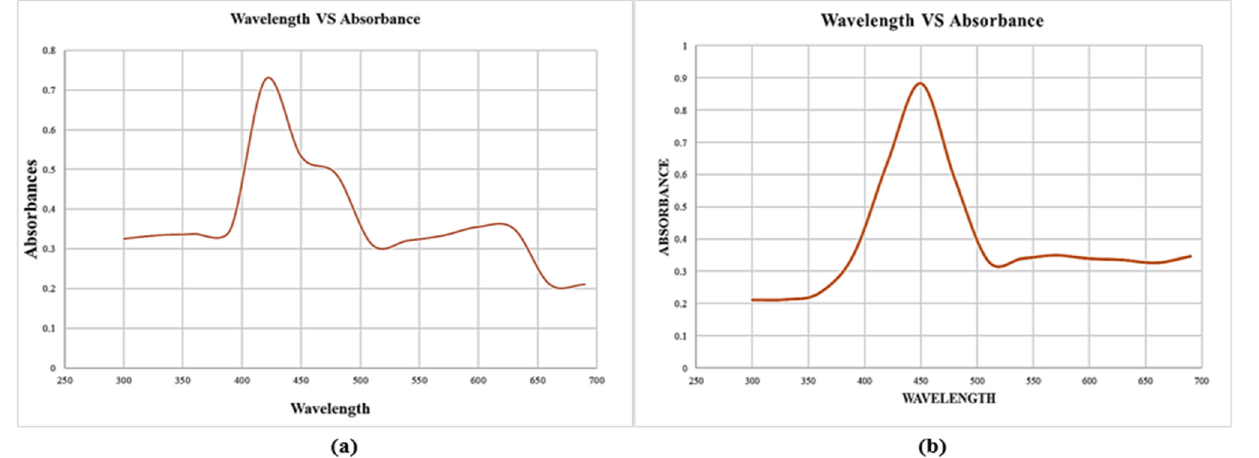
Figure 2. UV visible spectroscopy for silver nanoparticles synthesized using Acer oblongifolium plant